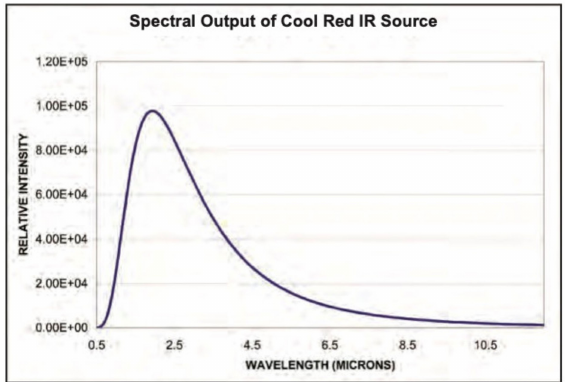
Figure 3. Intensity of Cool Red illumination source and its dependence on